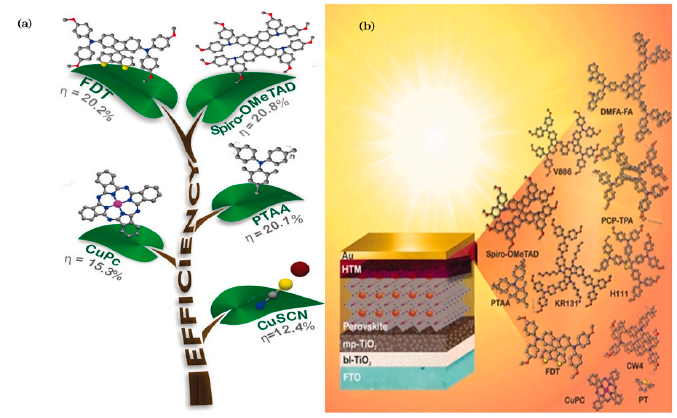
Figure 4. ( a ) The efficiency improvement tree of perovskite solar cell using different hole transporting layers. ( b ) Device architecture and molecular structure of commonly used hole transporting materials. Reproduced with permission from ref [47].